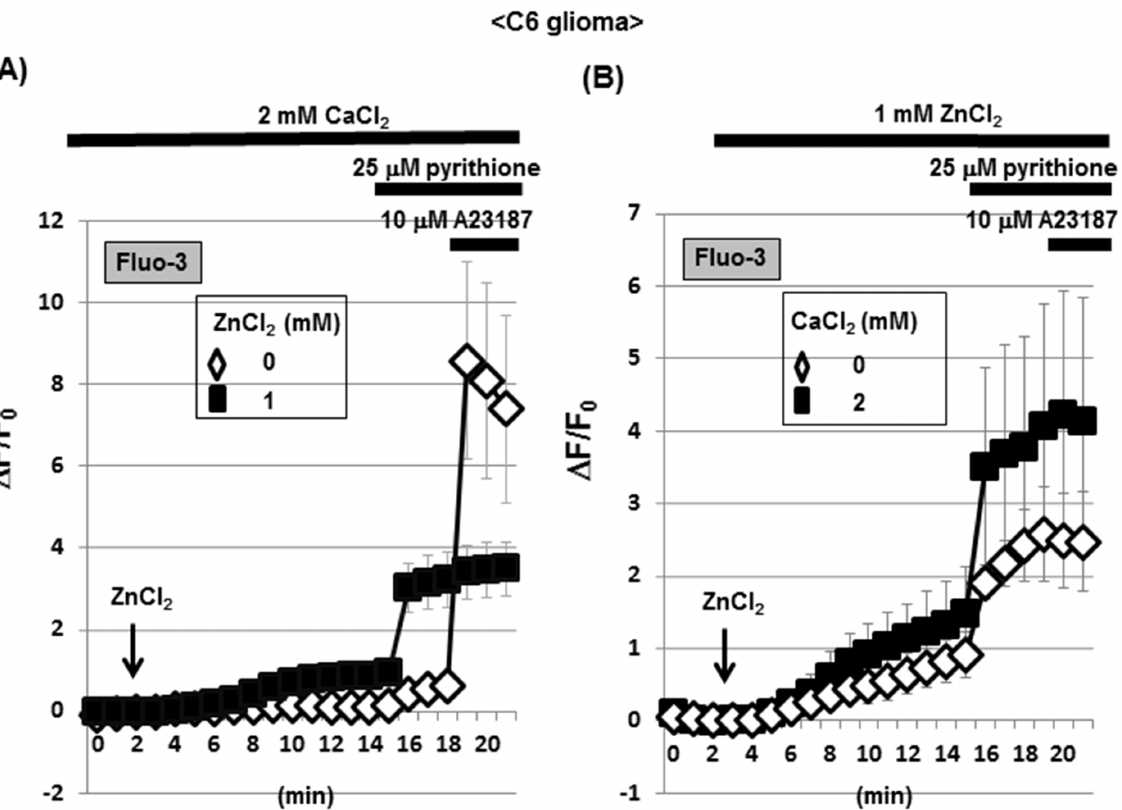
Fig 1. Effects of ZnCl 2 on Fluo-3 fluorescence in C6 glioma cells. (A) C6 glioma cells were cultured for 24 h, followed by loading of Fluo-3 in the presence of CaCl 2 and subsequent determination of the fluorescence intensity in either the presence or absence of ZnCl 2 every 1 min for 21 min. (B) Cells were loaded with Fluo-3 in either the presence or absence of CaCl 2 , followed by determination of the fluorescence intensity in the presence of ZnCl 2 every 1 min. Values are the mean ± S.E. of the rate of fluorescence change in 3 different